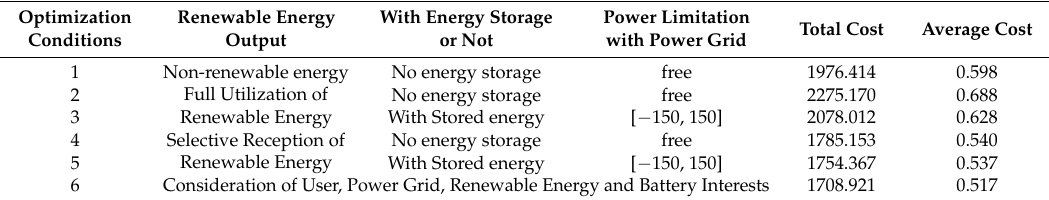
Table 4. Total cost and average cost of microgrids under different optimization